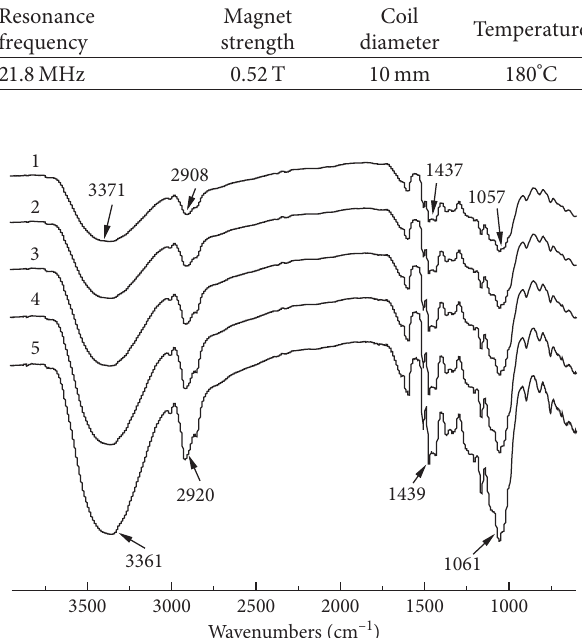
Figure 6: IR of the phenolic resin recycled powder with different particle sizes. 1, 2, 3, 4, 5: particle size of 60 mesh, 80 mesh, 120 mesh, 160 mesh, 200